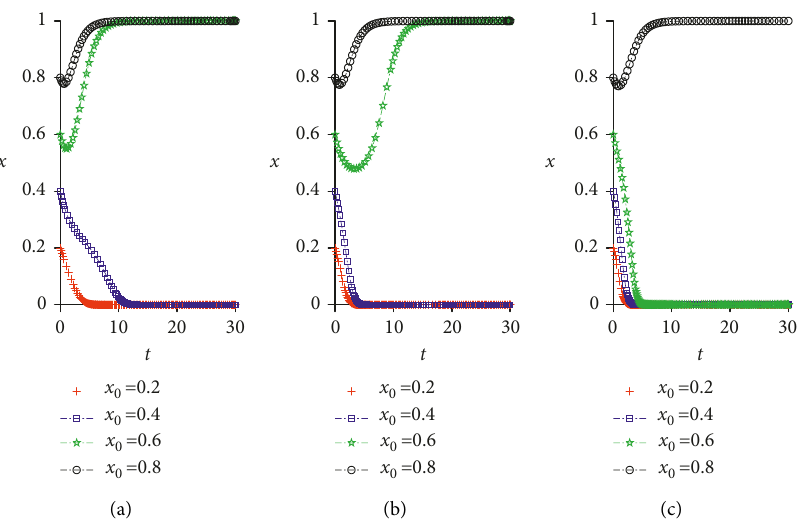
Figure 7: Impact of C s on system evolution. Comparing (a), (b), and (c), as independently) decreases, the probability of the system evolving to the ideal state increases. (a) C s